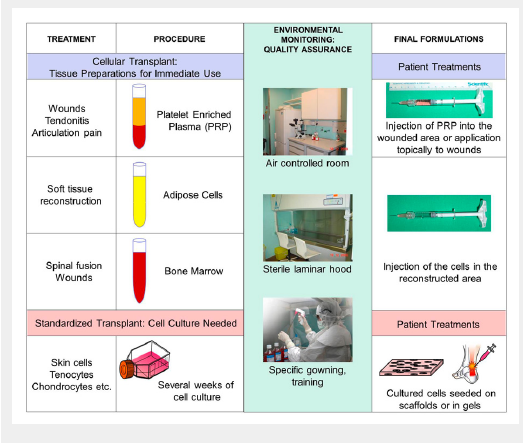
Progenitor human tenocyte cell bank production, capacity and usage for off-the-shelf therapeutic options for tendinopathies. From one single tendon tissue (2 mm 3 , organ donation of foetal Achilles tendon tissue at 14 weeks gestation), clinical cell banks can be produced including parental primary cultures, Master and Working Cell Banks that contain 200 vials each of progenitor tenocytes at low passages (P. 3–6). Expansion of cells produces high quantities of cells that can be stocked in vapor phase of liquid nitrogen (–165 °C) providing cell stocks for hundreds of thousands of patients. Cells can be administered in hydrogels or on other